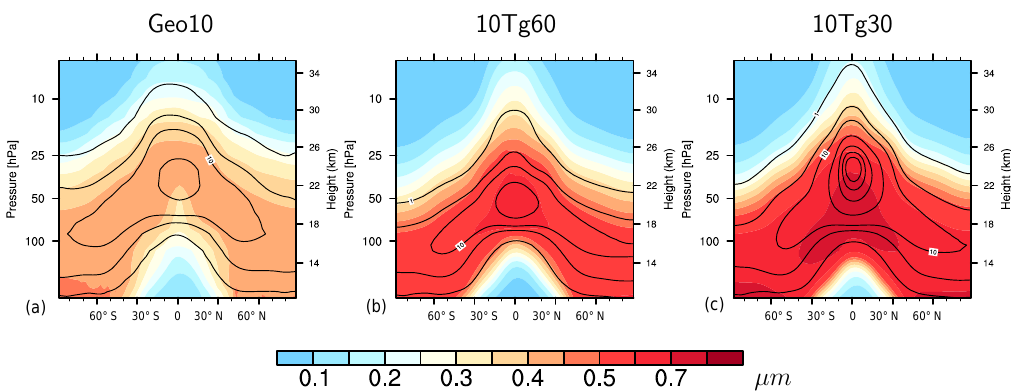
Figure 9. Zonal mean of effective radius [µm] of sulfate aerosols for experiments Geo10 (a) , 10Tg60 (b) , and 10Tg30 (c) with an injection rate of 10Tg ( S ) yr − 1 . Contour lines for sulfate aerosol mass mixing ratio [ppm] are plotted for 1, 5, 10, 25, 50, 75, 100ppm.